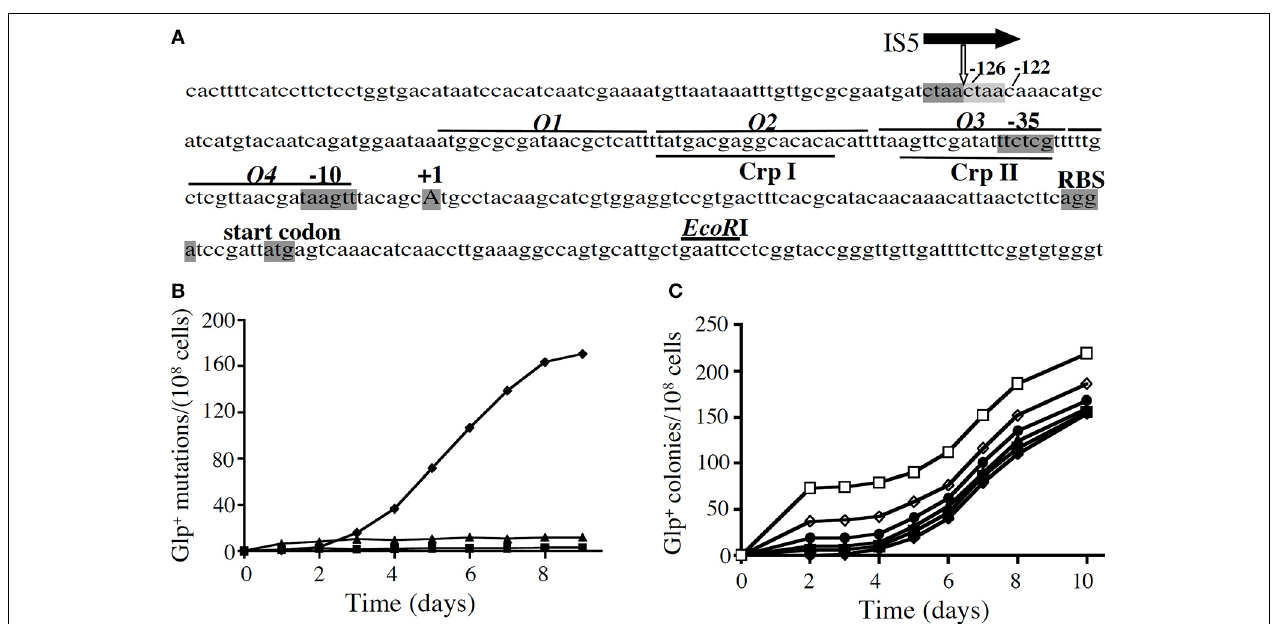
FIGURE 1 | The appearance of Glp + mutations in a crp genetic background. (A) The glpFK promoter region. The transcriptional initiation site ( + 1), the − 10 and − 35 hexamers of the promoter, the ribosome binding site (RBS) and the start codon for glpF are shaded. The GlpR binding sites ( O1–O4 ; lines above the sequence) and CRP binding sites (CrpI and CrpII; lines below the sequence) are also shown. The location of the IS5 element upstream of the promoter is indicated by the vertical white arrow below the horizontal black arrow representing IS5. The two 4-nucleotide direct repeats (ctaa), caused by IS5 insertion, are shaded dark and light gray, respectively. (B) Glp + mutations in a crp genetic background in various media: solid M9 minimal media + 1% glycerol ( (cid:2) ), 0.01%